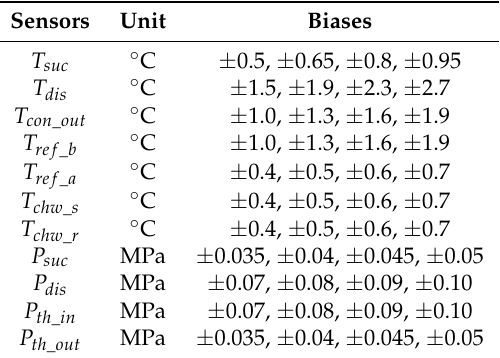
Table 4. Biases added in different